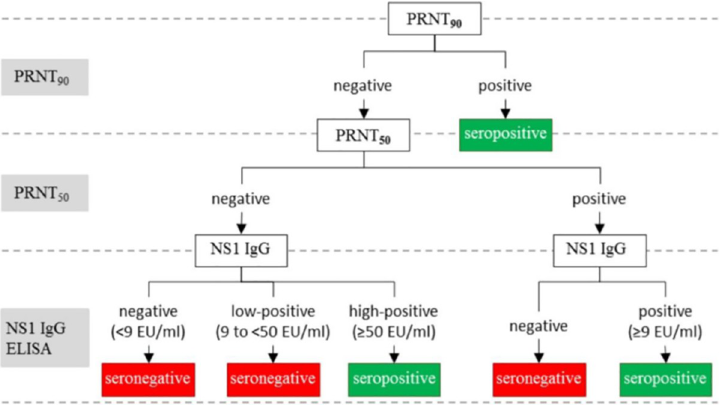
Fig 1. Algorithm for using PRNT90, PRNT50, and dengue NS1 IgG ELISA for reference dengue serostatus determination [12]. I AU : AbbreviationlistshavebeencompiledforthoseusedthroughoutFigs 1 and 2 andTable 1 : Pleaseverifythatallentriesarecorrect : gG, immunoglobulin G; EU/ml, ELISA Units per milliliter; NS1, nonstructural protein 1; PRNT 50 , Plaque Reduction Neutralization Test 50; PRNT 90 , Plaque Reduction Neutralization Test